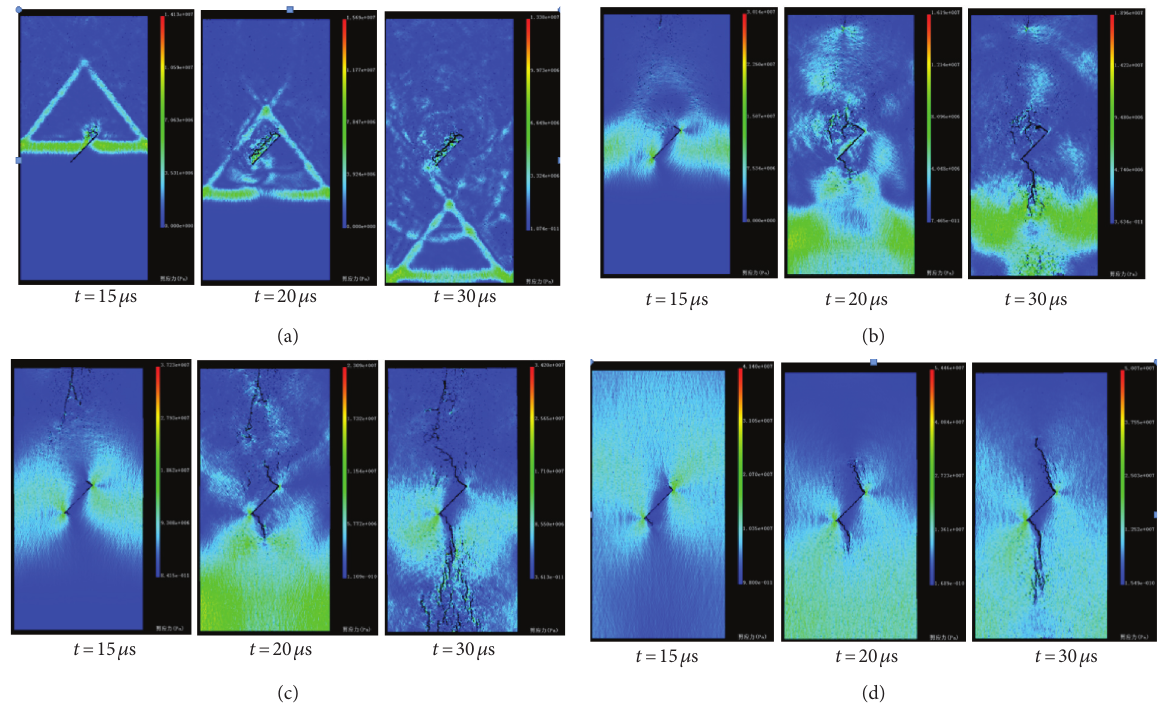
Figure 6: Failure process of flawed rock specimen with α � 45 ° when subjected to stress wave from I to IV. (a) Failure process of flawed rock specimen with α � 45 ° when subjected to stress wave I. (b) Failure process of flawed rock specimen with α � 45 ° when subjected to stress wave II. (c) Failure process of flawed rock specimen with α � 45 ° when subjected to stress wave III. (d) Failure process of flawed rock specimen with α � 45 ° when subjected to stress wave IV.